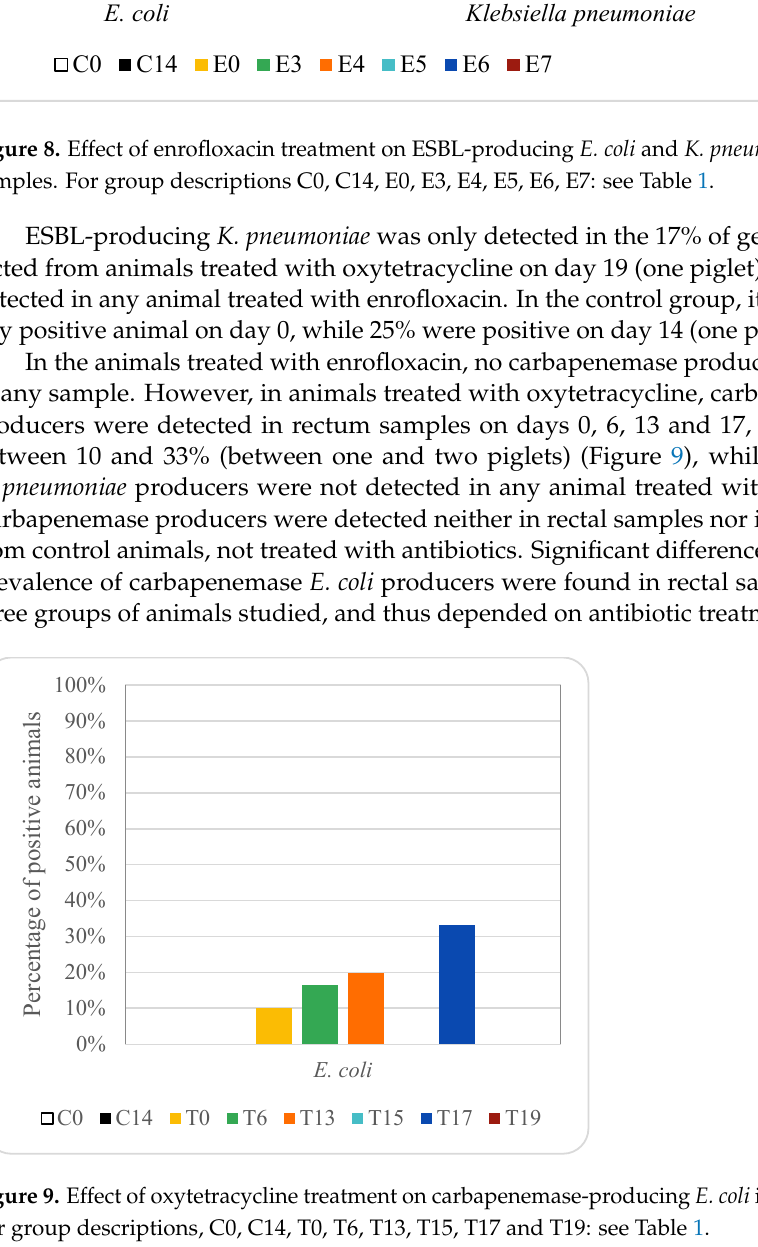
Figure 8. Effect of enrofloxacin treatment on ESBL-producing E. coli and K. pneumoniae in pig genital samples. For group descriptions C0, C14, E0, E3, E4, E5, E6, E7: see Table 1.